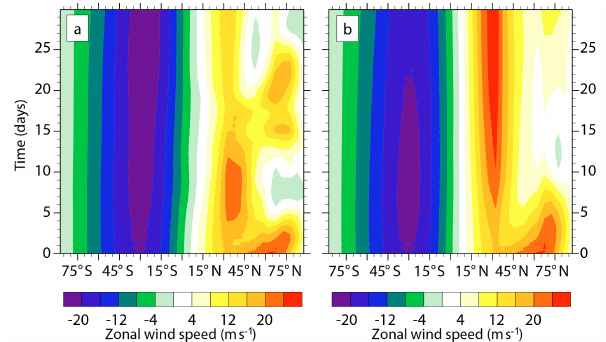
Figure 4. Hovmöller diagram of the zonal-mean zonal wind for the SSWbox simulation (a) and the SSWzon simulation (b) at 6 .